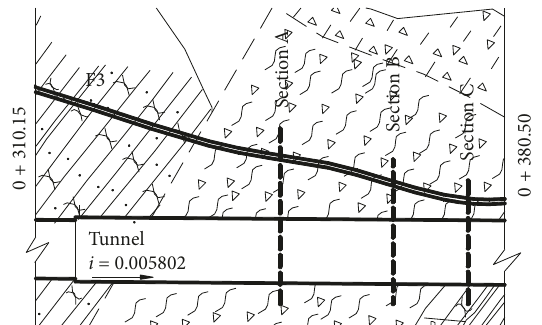
Figure 14: Mining tunnel, F3 fault, and monitoring section.